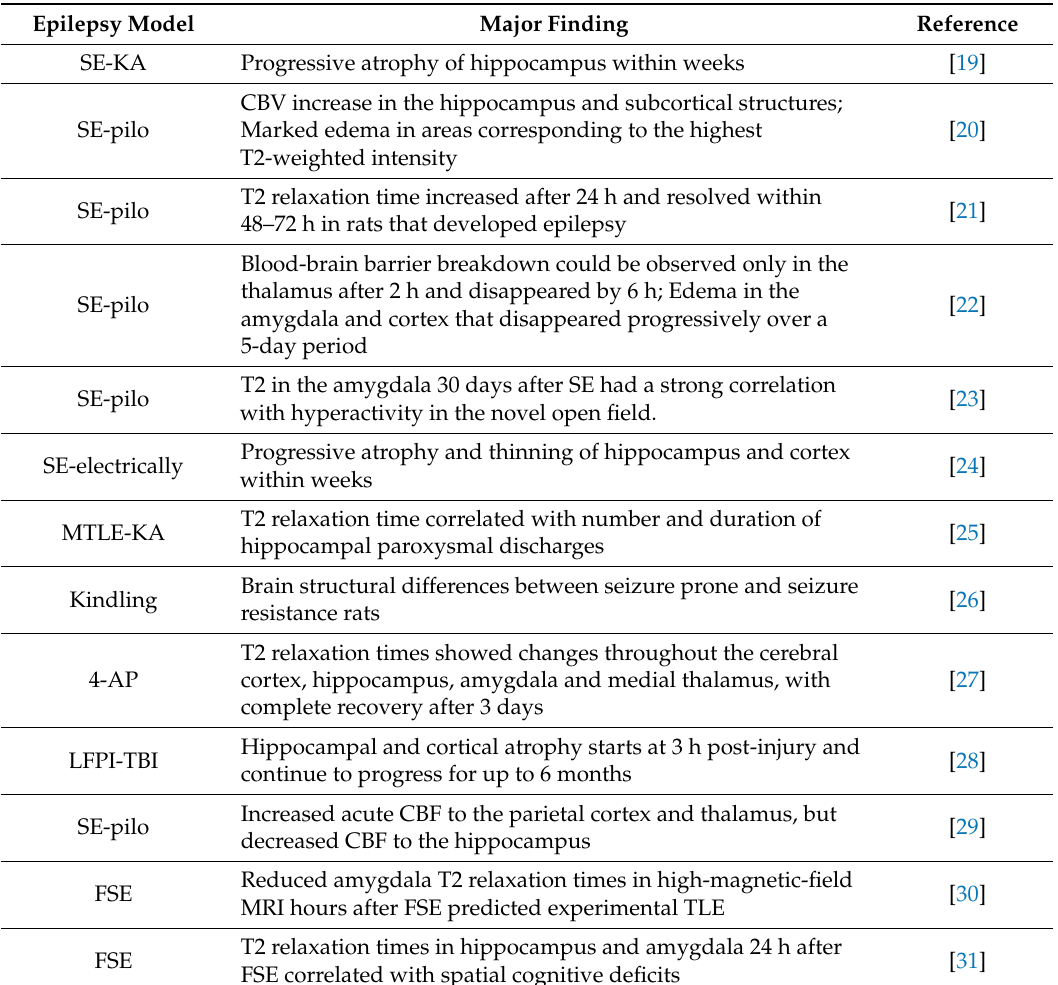
Table 2. List of T1 and T2-weighted magnetic resonance imaging (MRI)-based studies and potential biomarkers for